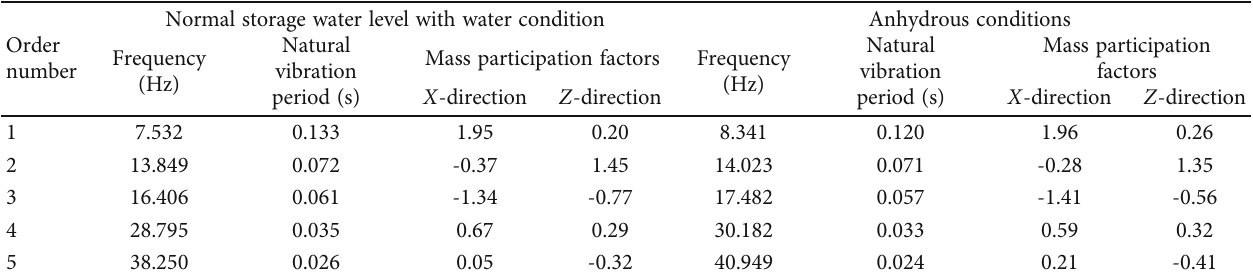
Table 2: Calculation results of natural vibration characteristics under di ff erent working